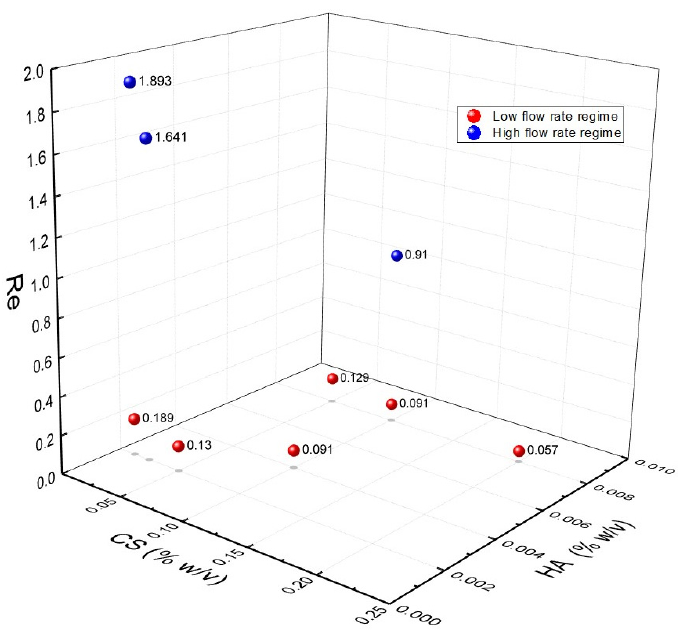
Figure 6. Characterization of the fluidodynamic regime through Reynolds numbers at different pol- ymer concentrations at low (0.6–0.3–0.6 μ L/min) and high (6–3–6 μ L/min) flow rate regimes. polymer concentrations at low (0.6–0.3–0.6 µ L/min) and high (6–3–6 µ L/min) flow rate